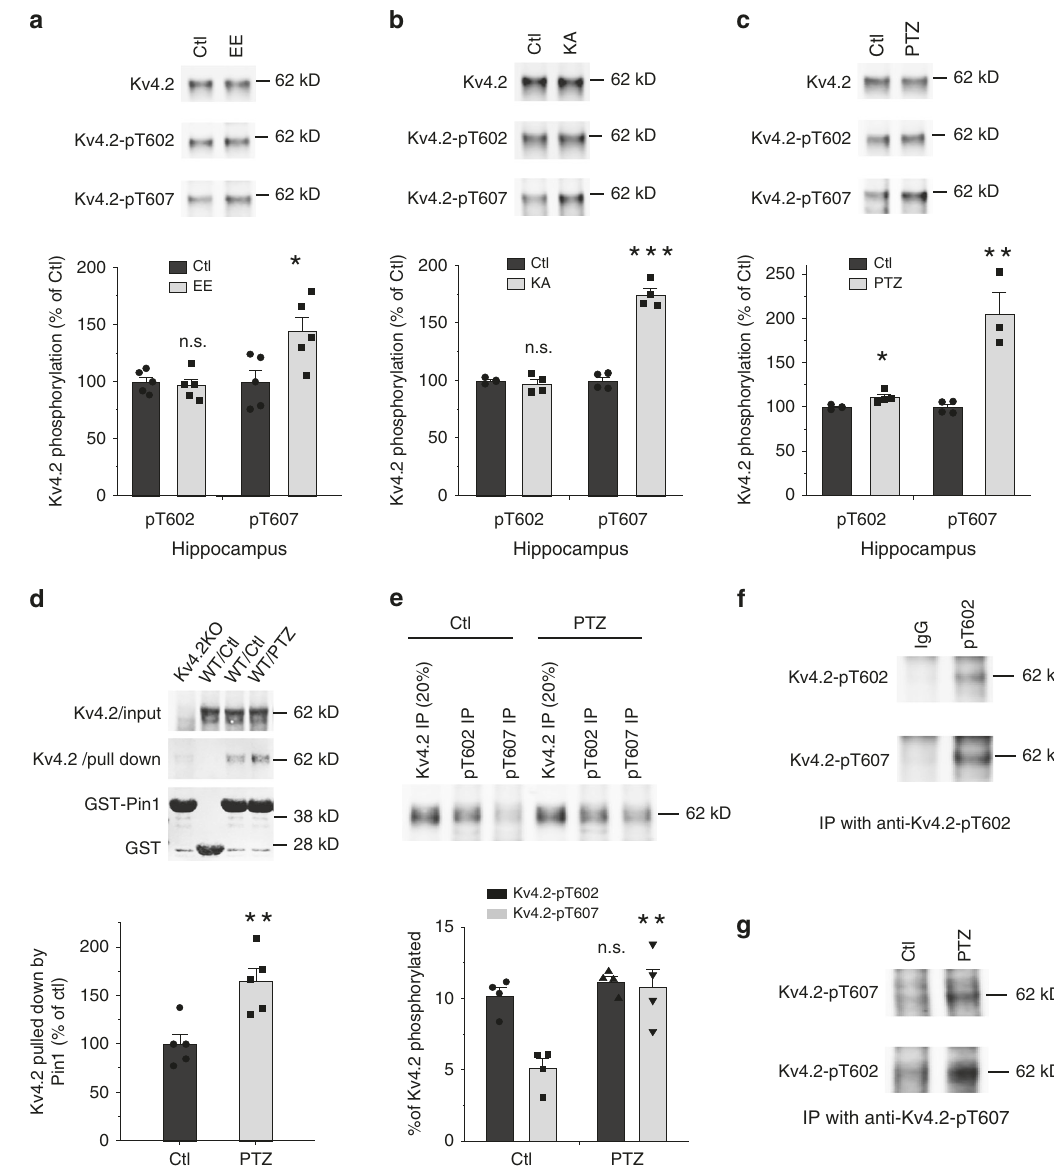
Fig. 2 Enriched novel environment exposure and seizure induce Kv4.2 phosphorylation at a Pin1 binding site. a Enriched novel environment (EE, 1 h) induces phosphorylation of Kv4.2 at Thr607 but not Thr602 in mouse hippocampus. n = 5 in each group. T -test, * p < 0.05. b Kainic acid-induced seizure (25 mg/kg, i.p., 15 min) induces phosphorylation of Kv4.2 at Thr607 but not Thr602 in mouse hippocampus. n = 4 in each group. T -test, *** p < 0.001. c PTZ-induced seizure (50 mg/kg, i.p., 15 min) induces phosphorylation of Kv4.2 at Thr607 and Thr602 in mouse hippocampus. n = 4 in each group. * p < 0.05, T -test, ** p < 0.01. d PTZ-induced seizure increases Pin1 binding to Kv4.2. GST or GST-Pin1-linked beads were incubated with brain lysates from mice subjected to saline or PTZ administration. n = 5 in each group. T -test, ** p < 0.01. e Mouse brain lysates from WT mice w or w/o PTZ administration (50 mg/kg, i.p., 15 min) were incubated with excess anti-Kv4.2, anti-Kv4.2-pT602 or anti-Kv4.2-pT607 antibodies. Immunoprecipitation (IP) samples were blotted with Kv4.2 antibody. In WT mouse brains, pT607 Kv4.2 is almost half as abundant as pT602. However, PTZ administration increased the amount of pT607 until it reached a similar level as pT602. n = 4 for each group. T -test, ** p < 0.01. f Mouse brain lysates from WT mice were incubated with excess anti-Kv4.2-pT602 or normal IgG antibodies. Immunoprecipitation (IP) samples were blotted with anti-Kv4.2 pT607 antibody. pT602 and pT607 dual phosphorylation was observed in mouse brain. Data was repeated in two independent experiments. g Mouse brain lysates from WT mice w or w/o PTZ administration (50 mg/kg, i.p., 15 min) were incubated with excess anti-Kv4.2-pT607 antibody. IP samples were blotted with anti-Kv4.2 pT602 antibody. PTZ-induced seizure increases the dual phosphorylation of T602 and T607 in mouse brain. Data was repeated in two independent experiments. Data are presented as mean ±